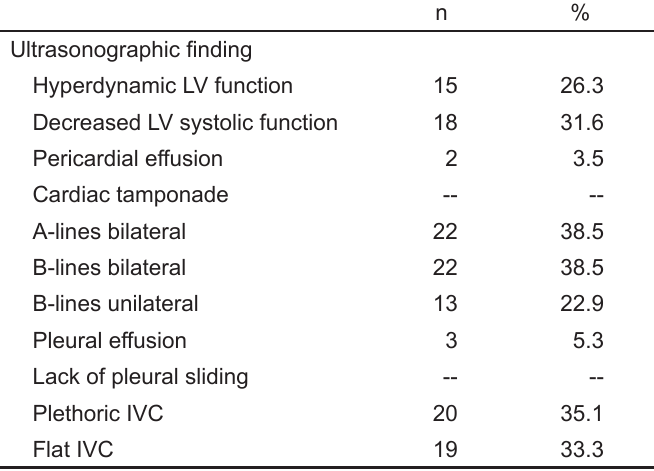
Table 2. Ultrasonographic findings among all 57